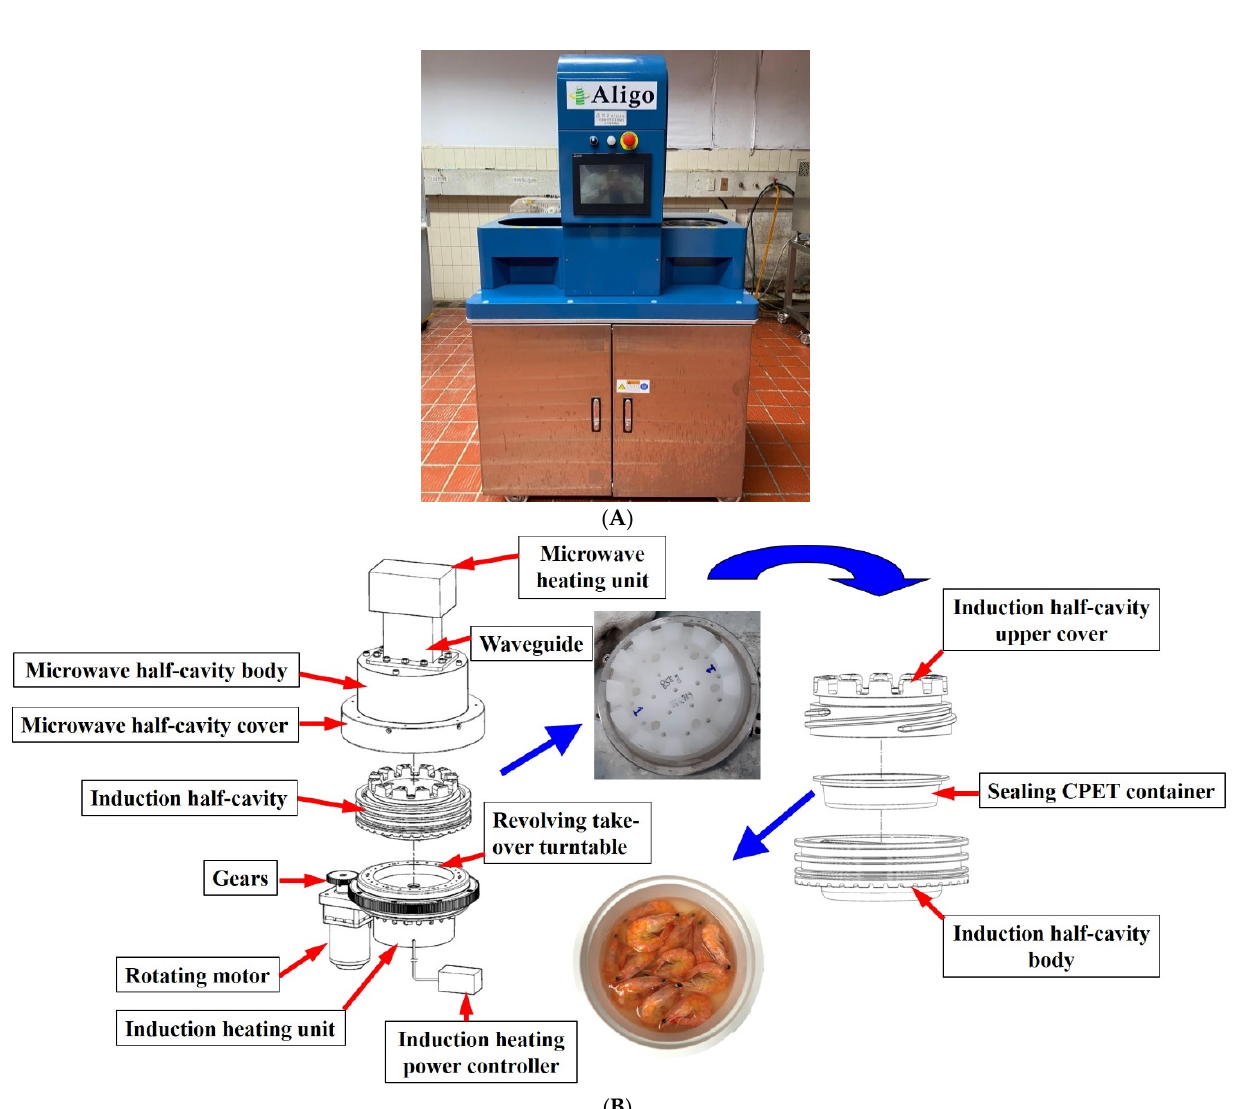
Figure 1. A scaled-up and commercial scale MAIH system-Aligo-2 TM , developed and installed at Bottle Top Machinery Co. Ltd., Taiwan. ( A ) Equipment view. ( B ) Schematic diagram.